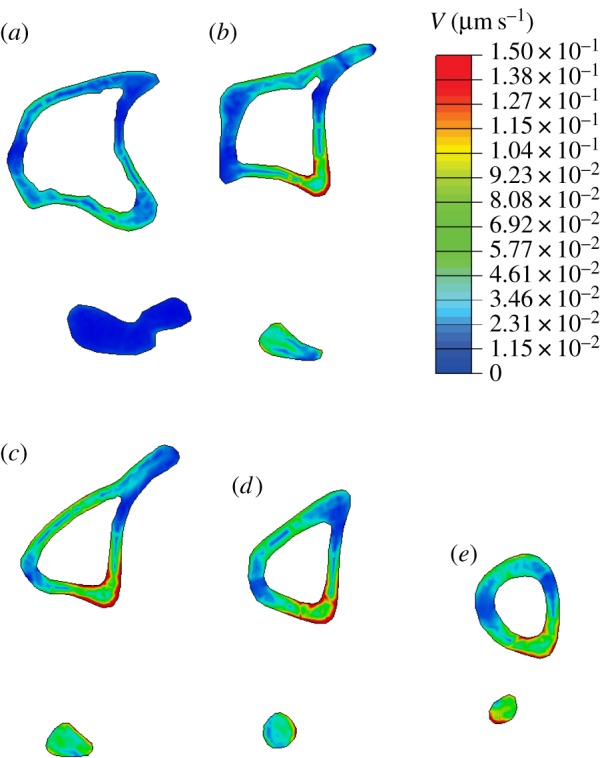
Contour plots of fluid velocity, V, obtained at t = 0.025 s (peak load) for different Z positions in the initial geometry. Higher fluid velocity magnitudes obtained in the medial surface and around the interosseous crest. (a) Z = 0.1, (b) Z = 0.3, (c) Z = 0.5, (d) Z = 0.7 and (e) Z = 0.9.